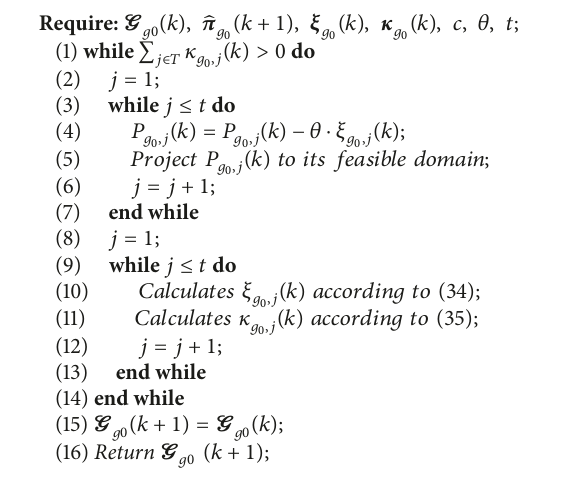
Algorithm 2: Day-ahead scheduling of power